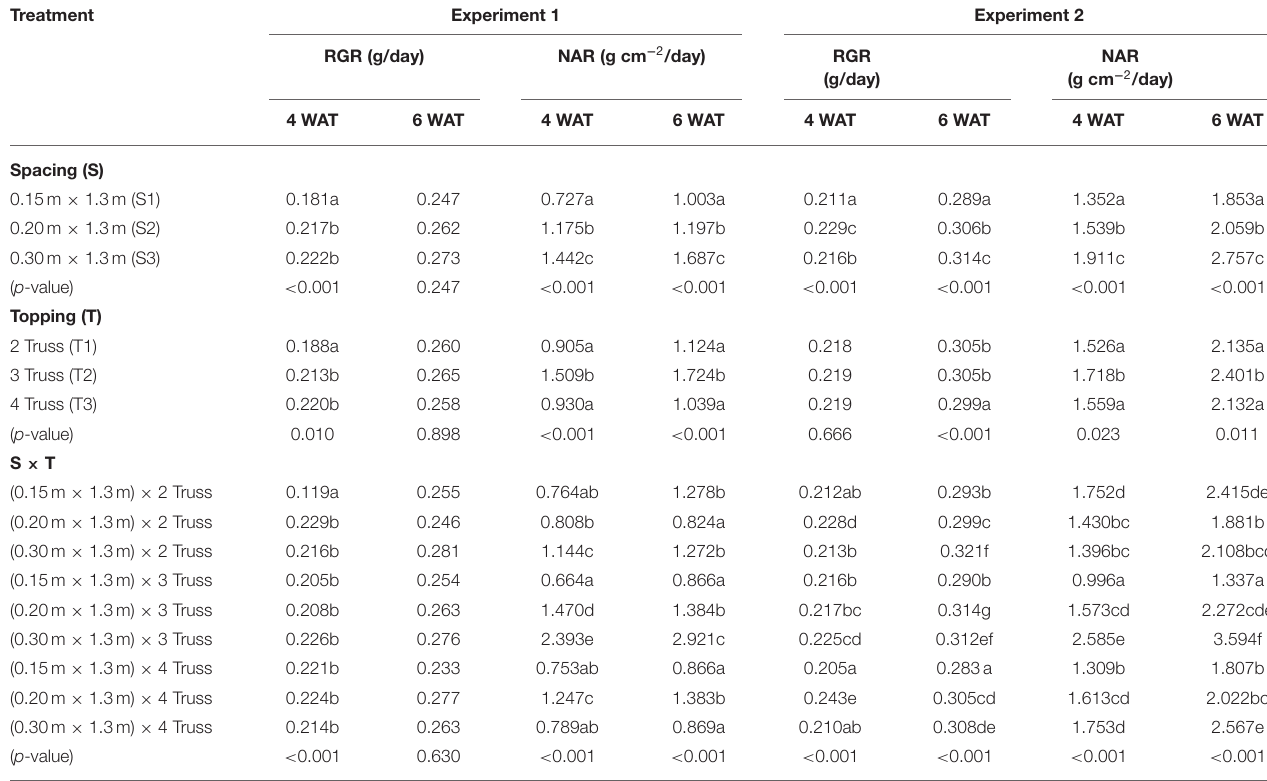
TABLE 8 | Effect of spacing and topping on relative growth rate (RGR) and net assimilation rates (NAR) of Solanum lycopersicum under greenhouse conditions.